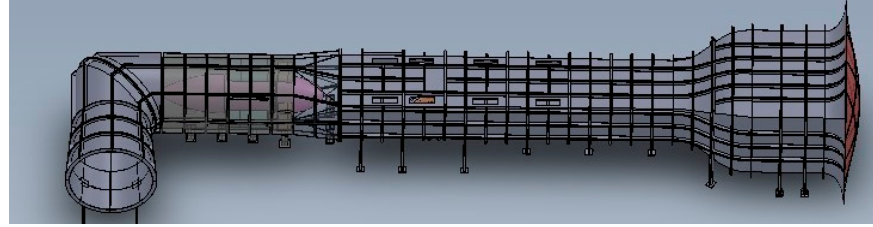
Figure 2. The aerodynamic contour of the wind tunnel. The target pressure-measuring model is a square-shaped cylinder with an aspect ratio of 4. To avoid the influence of the scale ratio of the wind field on the test data, the wind field was set as a smooth uniform flow. The research object of this paper was the mean wind pressure coefficient and drag coefficient, so research results in uniform flow are also applicable to the turbulent field in the atmospheric boundary layer. For the isolated pressure model, wind tunnel tests of three scale ratios were carried out in this study. For the grouped building models, three scale ratios, eight relative positions, and two relative heights of the pressure model and the surrounding model were considered in this study. A total of 51 test conditions were carried out in this paper. The test models were defined as a large model, medium model, and small model, respectively, according to the scale ratio from large to small. If it is assumed that the real size of the tall building is 240 m high and 60 m wide, the scale ratios of the large model, medium model, and small model were 1/200, 1/300 and 1/600, respectively. Figure 3 shows the layout of the pressure points on the target pressure-measuring model. Figure 4 shows the layout of the grouped tall